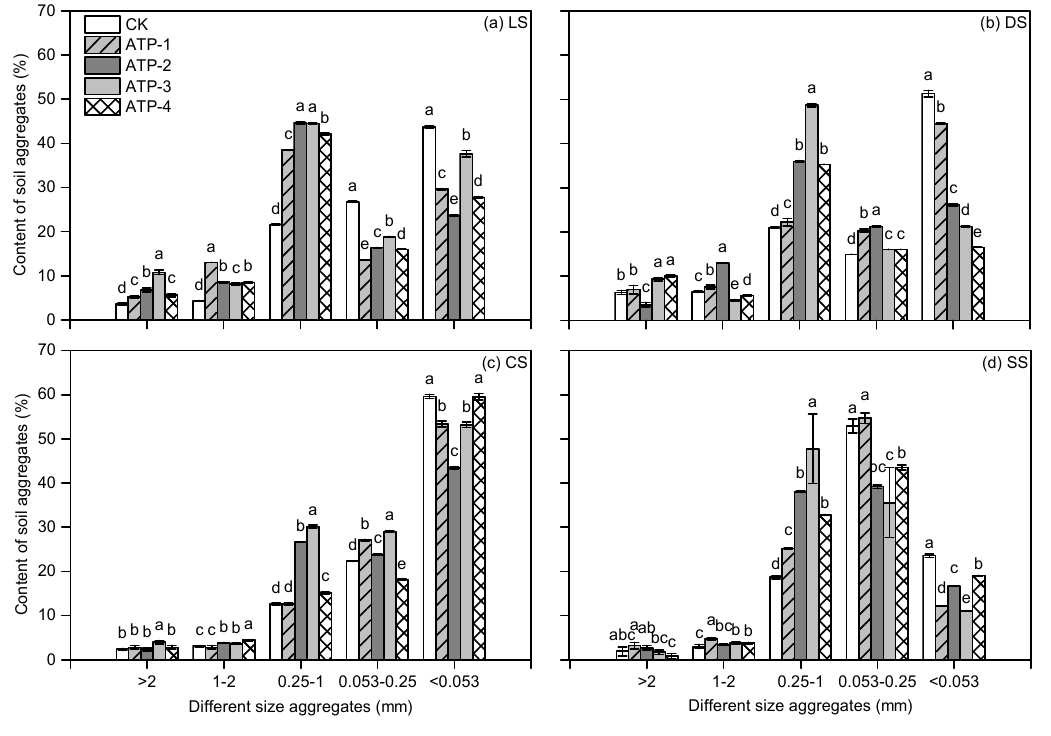
Figure 5. Composition of soil water-stable aggregates with lou soil (LS), dark loessial soil (DS), cultivated loess soil (CS), and sandy soil (SS). Different letters within a size fraction indicate significant differences between the four treatments ( p < 0.05). Error bars refer to the standard deviation. Table 5. Changes in soil aggregates (>0.25 mm) content, mean weight diameter, geometric mean diameter, and percentage of aggregate destruction with different material